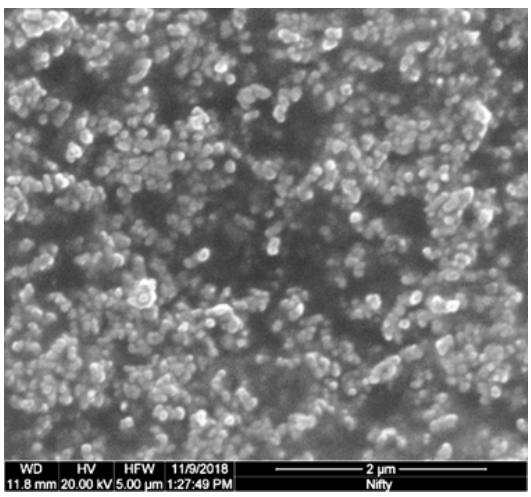
Figure 1. Scanning Electron Microscopy (SEM) image of the Carbon Black (CB) distribution in unprinted filament, showing CB particles and aggregates. The sample is prepared by the cryo- fracturing of PI-eTPU 85-700+ filament and imaged with an FEI Quanta